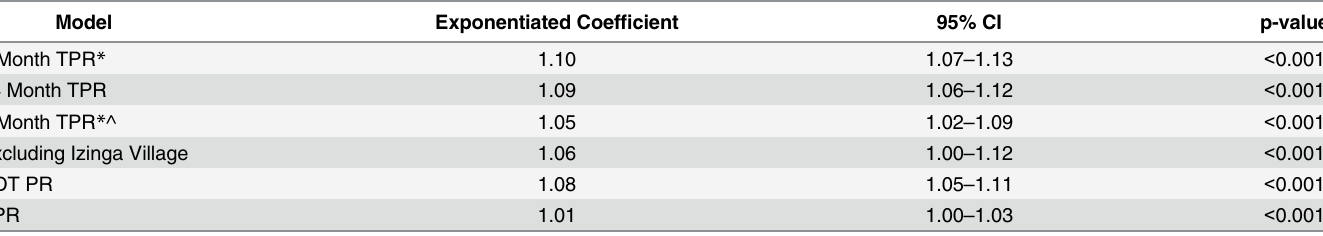
Table 4. Sensitivity models exploring the quantitative relationship between test positivity rate (TPR) and confirmed malaria case rate (CMCR).